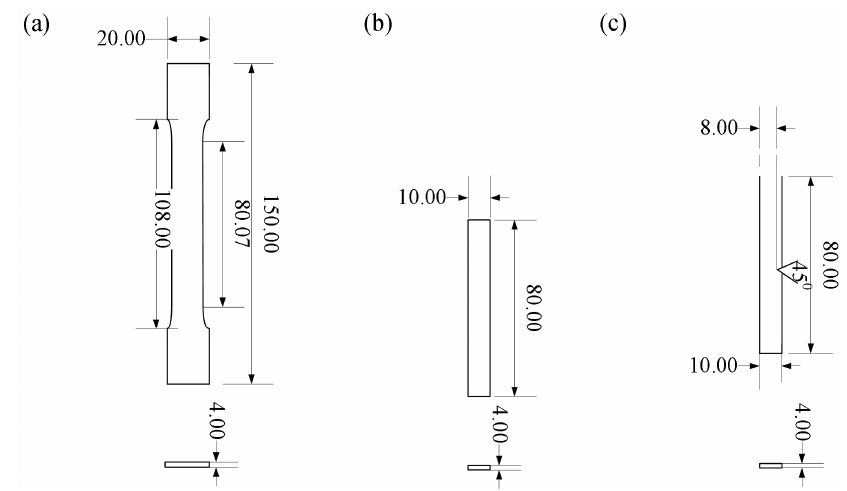
Figure 2. Geometric models of the mechanical test specimens. ( a ) Tensile specimen; ( b ) Bending specimen; ( c ) Impact specimen.